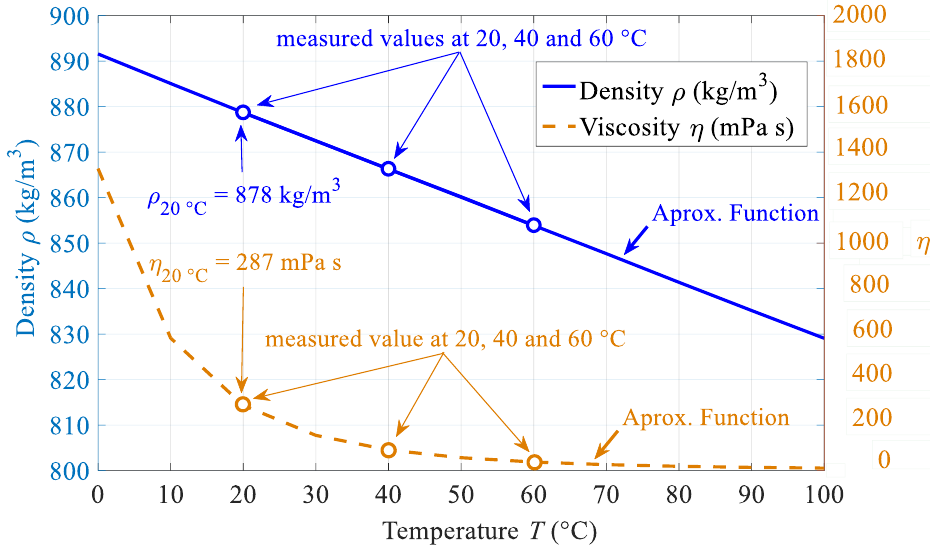
Figure 5. Temperature dependence of density and viscosity of mineral oil based magnetic fluid with 10.57% volume fraction of maghemite magnetic nanoparticles, three measured points and approximation function for the temperature range from 0 to 100 °C.